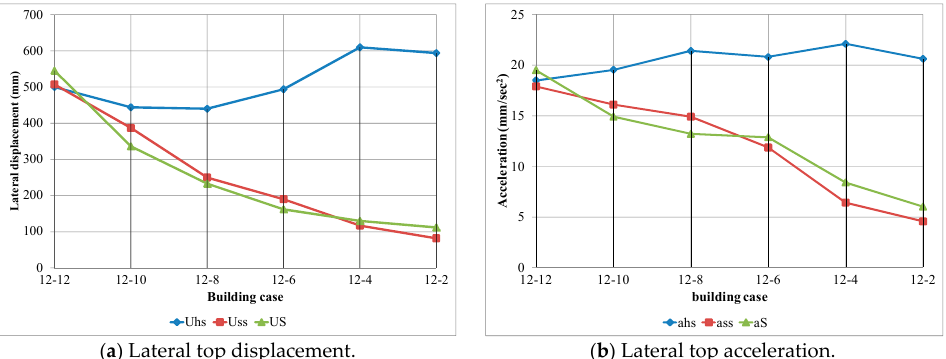
Figure 15. Comparison for top displacement and acceleration between the single and the two adjacent buildings with unequal foundation levels and SSI.